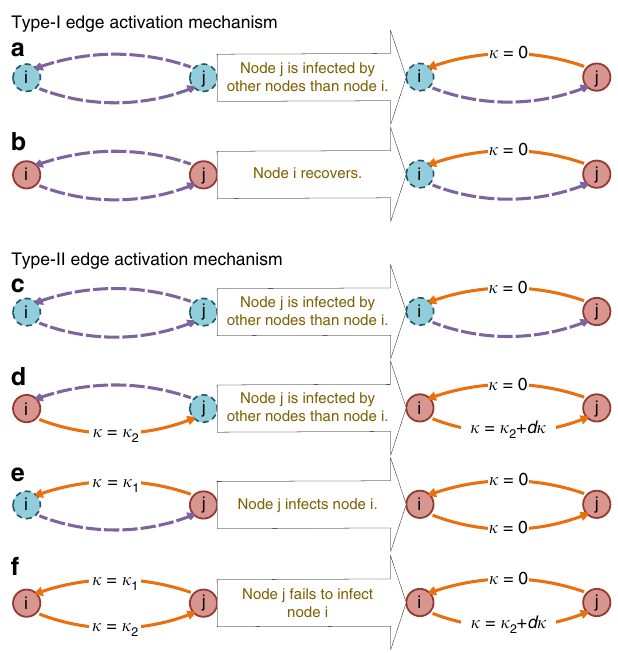
Fig. 1 Two mechanisms to activate edges. For the fi rst mechanism (type-I), there are two cases in which the state age of an active edge is set to zero: a the event is driven by the generation of infected node, b it results from the generation of an susceptible node. For the second mechanism (type-II), there are four independent scenarios for setting zero the age of an active edge: c , d the event occurs because of the generation of an infected node, e , f it is caused by the transmission of the disease. Blue dashed and red solid circles represent susceptible and infected nodes, respectively. Purple dashed and orange solid arrows denote nonactive and active edges, respectively. Each state transition takes place in an in fi nitesimal time interval d τ or d κ , where d τ = d